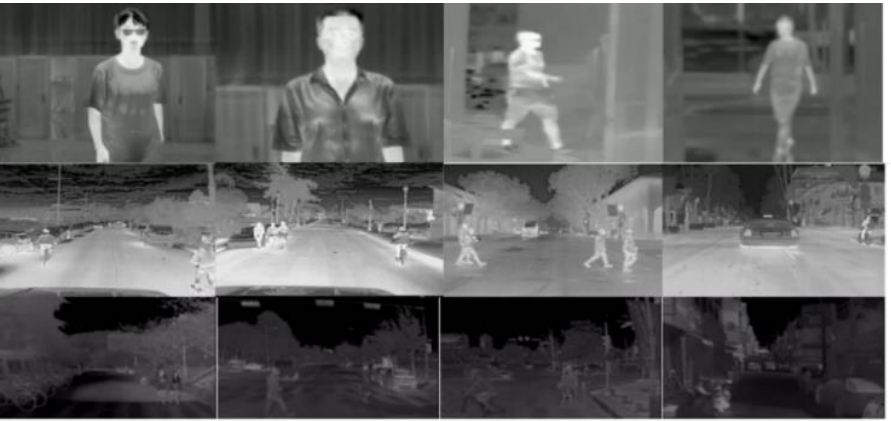
Figure 9. Example images from different night databases, Row 1: DHU Night dataset, Row 2: FLIR ADAS dataset, Row 3: KAIST dataset.